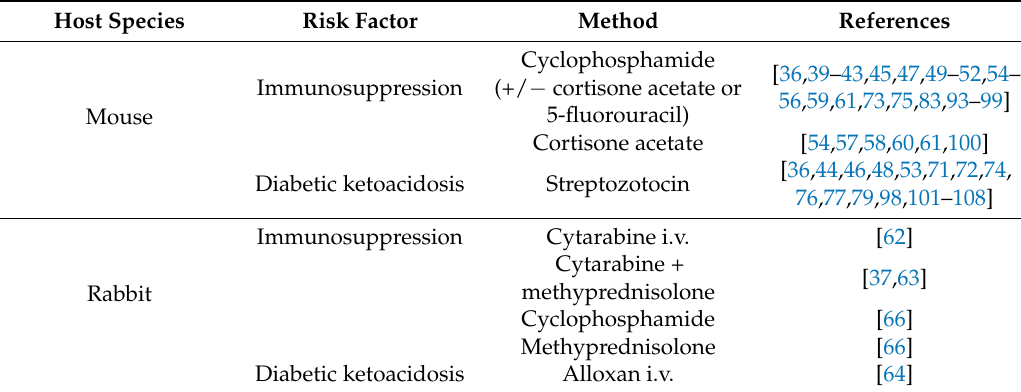
Table 2. The predisposing factors for mammalian mucormycosis